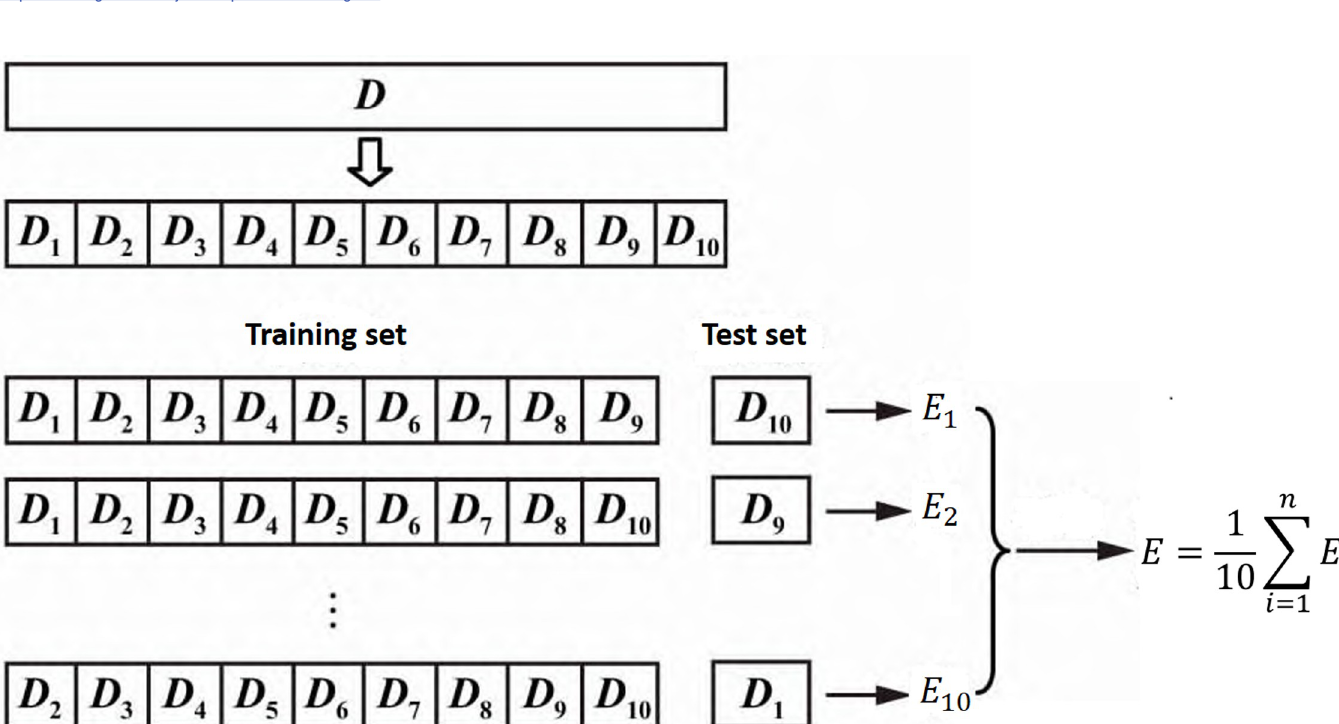
Fig 5. 10-fold cross-validation process description and implementation.